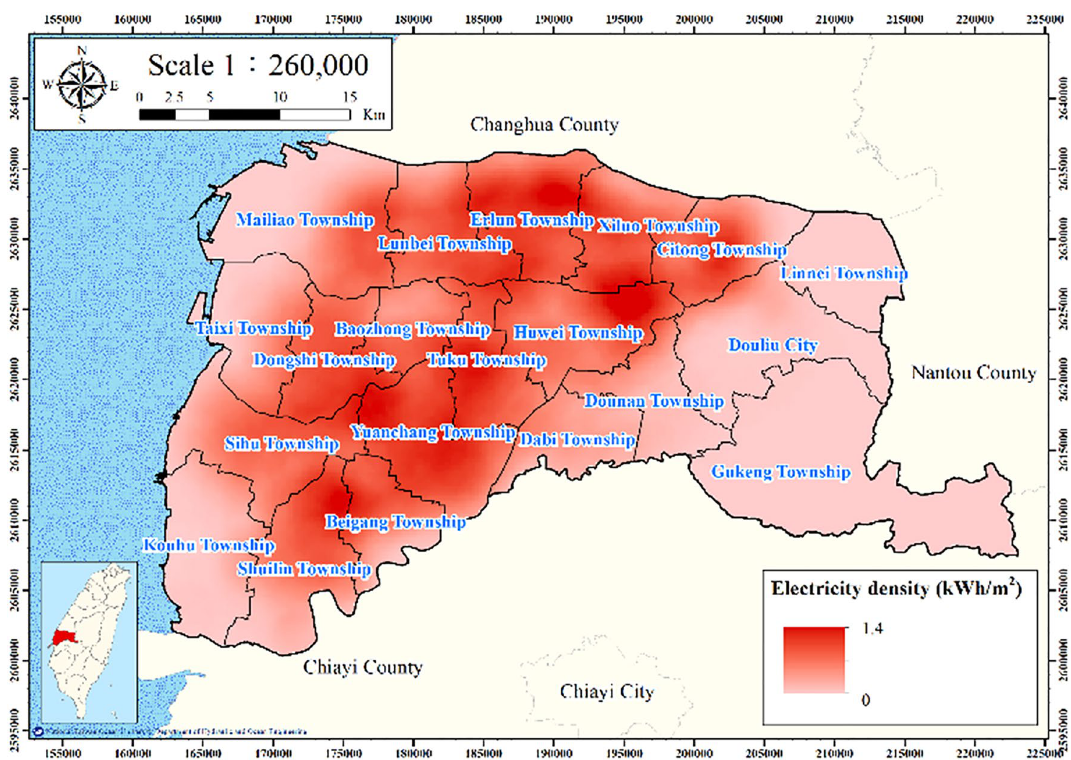
Figure 5. Electricity consumption of wells per unit square meter in Yunlin County. This figure was created using ArcGIS 10.6.1